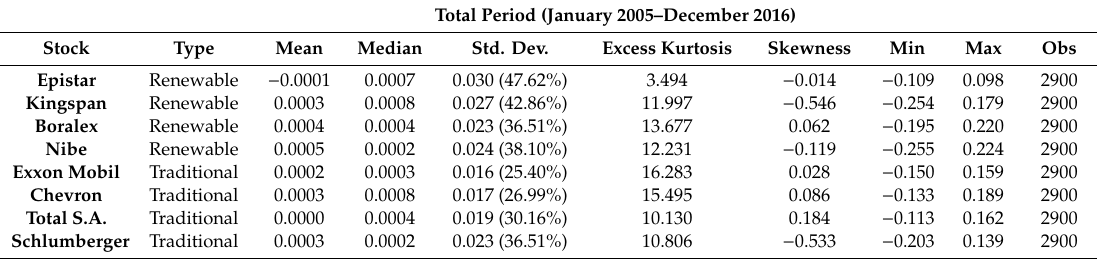
Table 2. Descriptive statistics of renewable and traditional energy